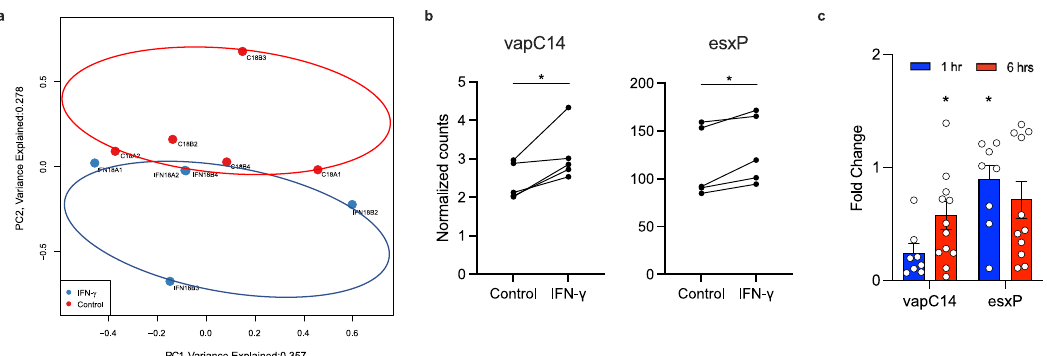
Fig. 5 IFN- γ induces transcriptional pro fi le changes in Mtb . A distinct transcriptional pro fi le is observed in Mtb when exposed to IFN- γ when analyzed by RNAseq and PCA ( a ) and IFN- γ regulates several genes of interest associated with virulence ( b ). This was con fi rmed by qPCR, which showed signi fi cant increase in these genes at 1 h and 6 h post-stimulation ( c ). Gene expression is presented as fold changes normalized to housekeeping gene. Data are shown as mean ± SEM of n = 8 – 12 technical replicates and represent at a minimum two independent experiments. T-test was used for the statistical